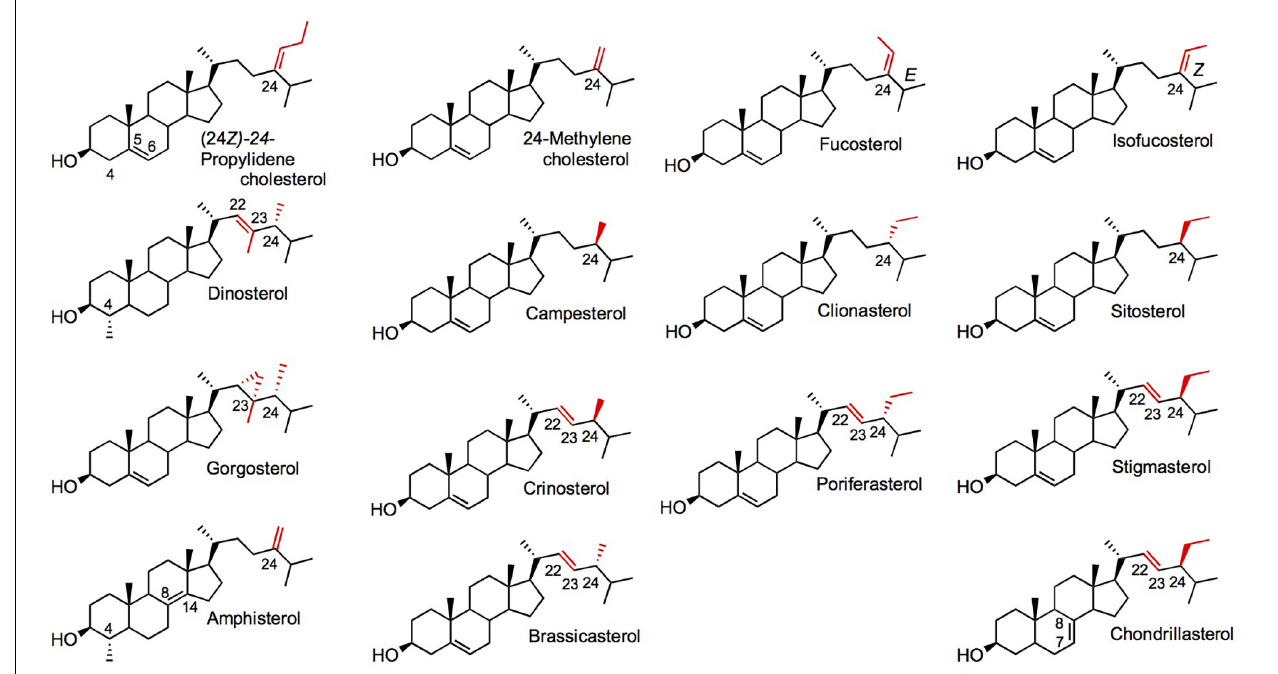
FIGURE 3 | Diverse sterols found in algae and plants. Side chain C22, C23, and C24 positions are in red. Chiral substituents at C24 of the sterol side chain are C24 α for a methyl or ethyl group in front: campesterol, sitosterol, crinosterol, stigmasterol, chondrillasterol; or C24 β for a methyl or ethyl group in back: dinosterol, clionasterol, gorgosterol, poriferasterol. Nomenclature as in Figure 1